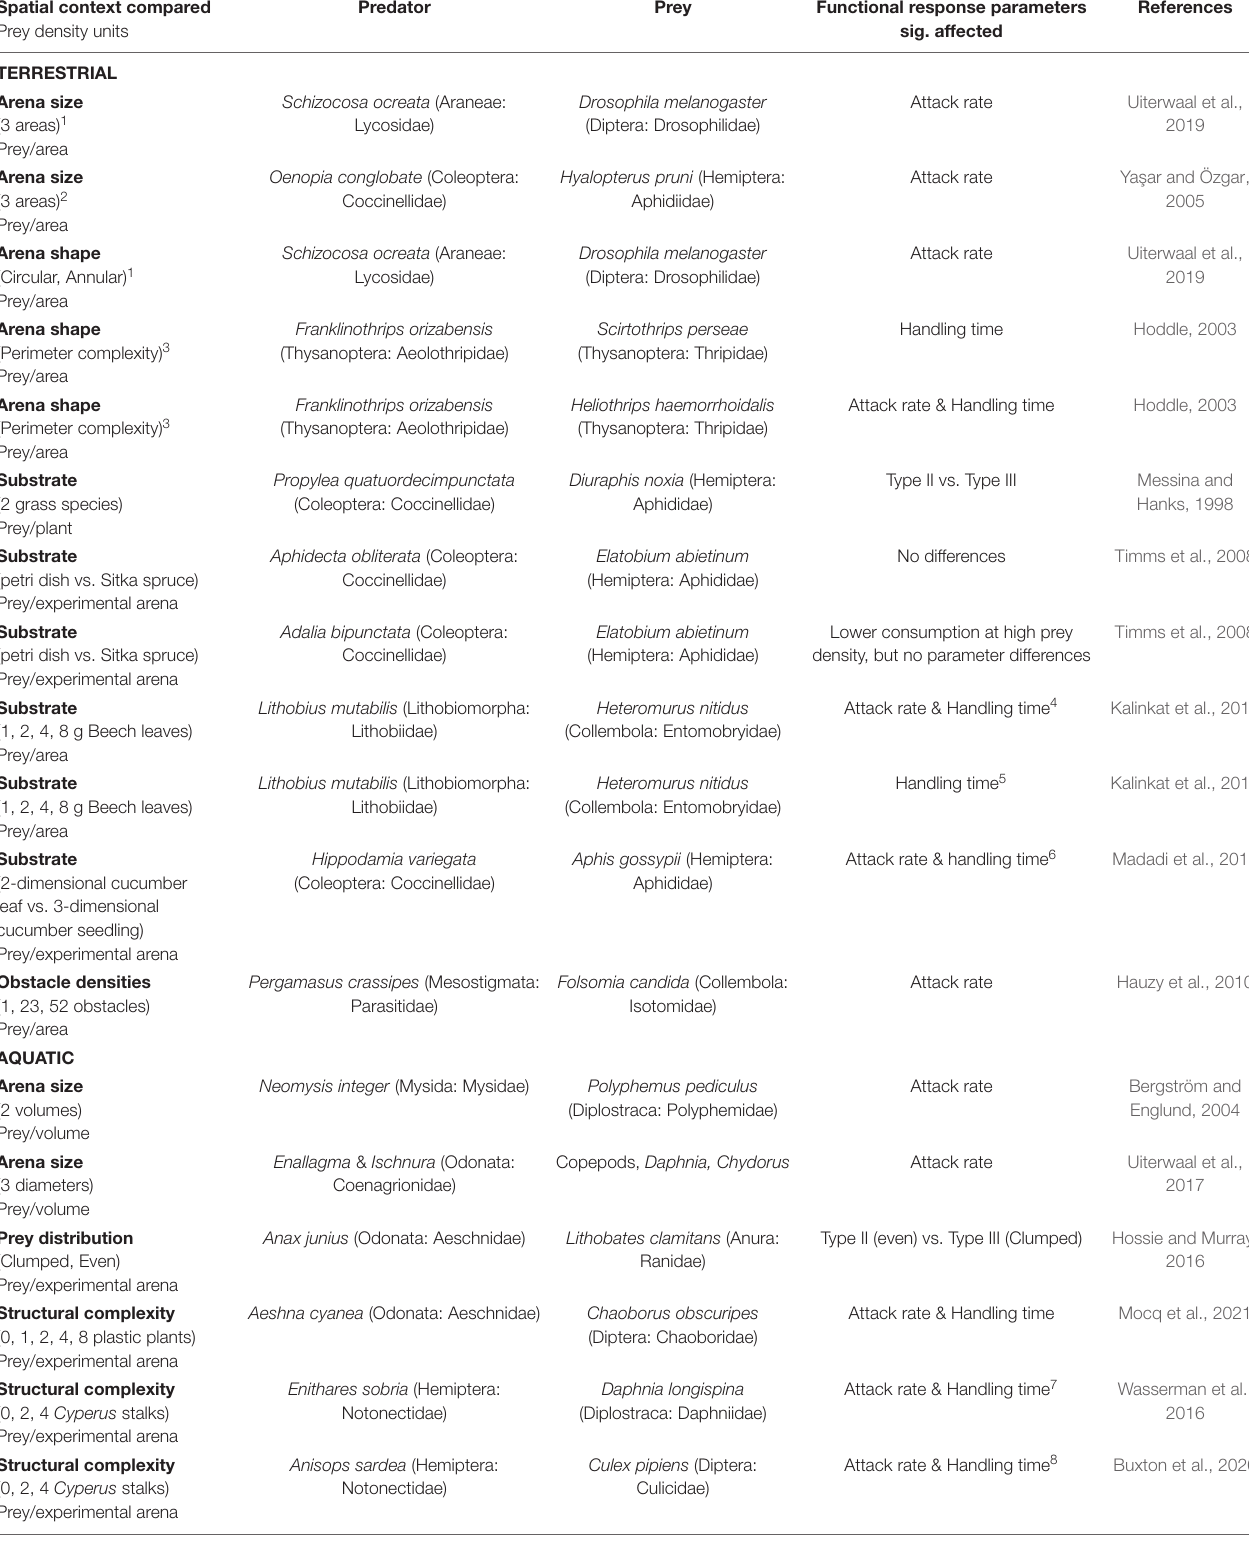
TABLE 1 | Summary of recent functional response experiments investigating the effects of spatial context on functional response type and parameter